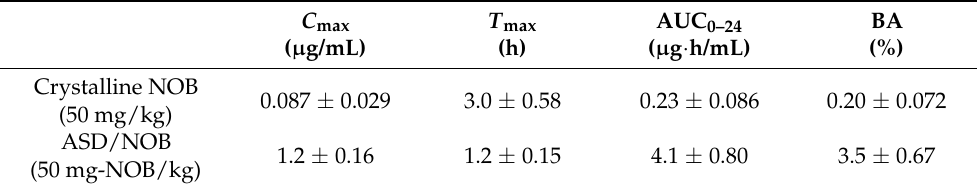
Figure 4. Plasma concentration-time profiles of NOB after oral administration of NOB samples (50 mg NOB/kg) in rats. ● , Crystalline NOB; △ , ASD/NOB. Data represent the mean ± SE of six ex- (50 mg NOB/kg) in rats. • , Crystalline NOB; (cid:52) , ASD/NOB. Data represent the mean ± SE of six periments. experiments. Table 1. Pharmacokinetic parameters of orally dosed NOB samples in rats. Table 1. Pharmacokinetic parameters of orally dosed NOB samples in